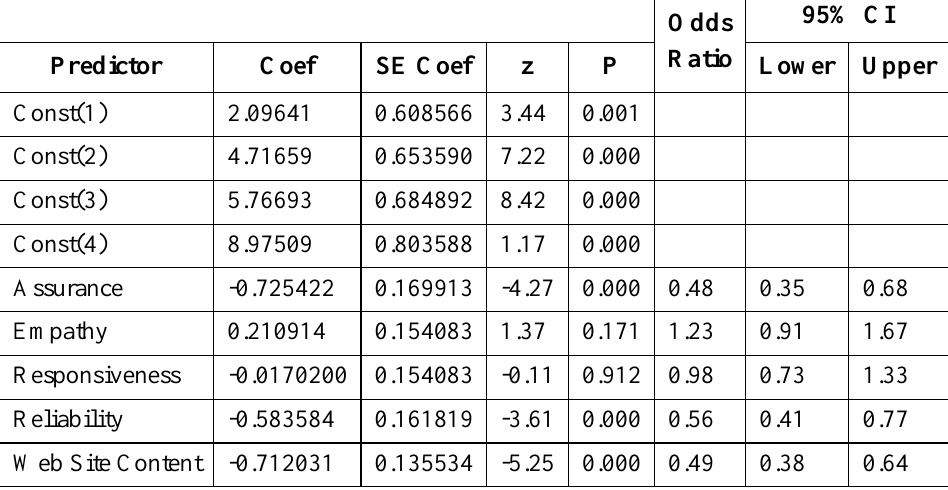
95% CI Odds Ratio